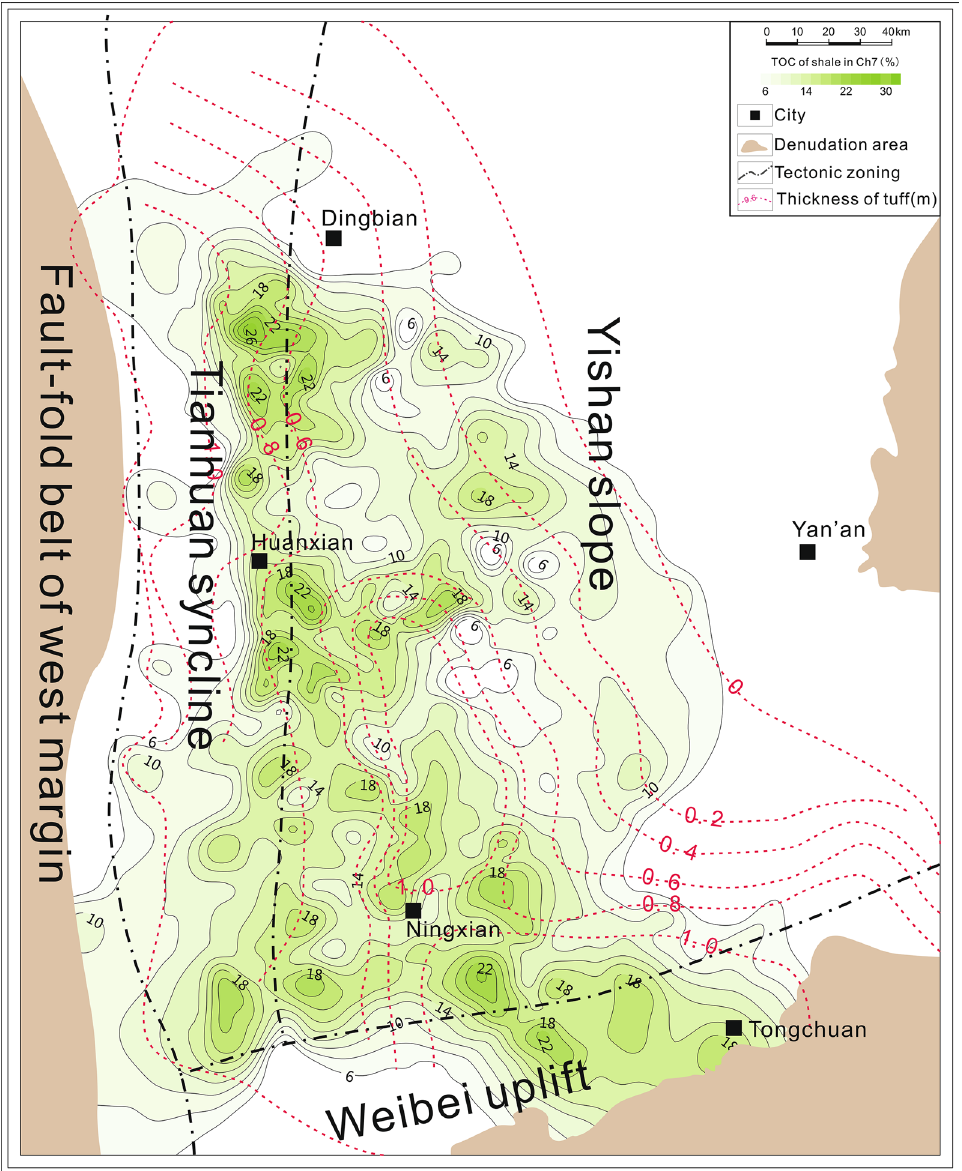
Figure 6. Distributions of accumulated tephra thicknesses and total organic carbon (TOC) in the Ch7 Member, Ordos Basin (Software: CorelDRAW Graphics Suite 2021, full 15-Day free trial. URL link: https:// www. corel draw. com/ en/ produ ct/ corel